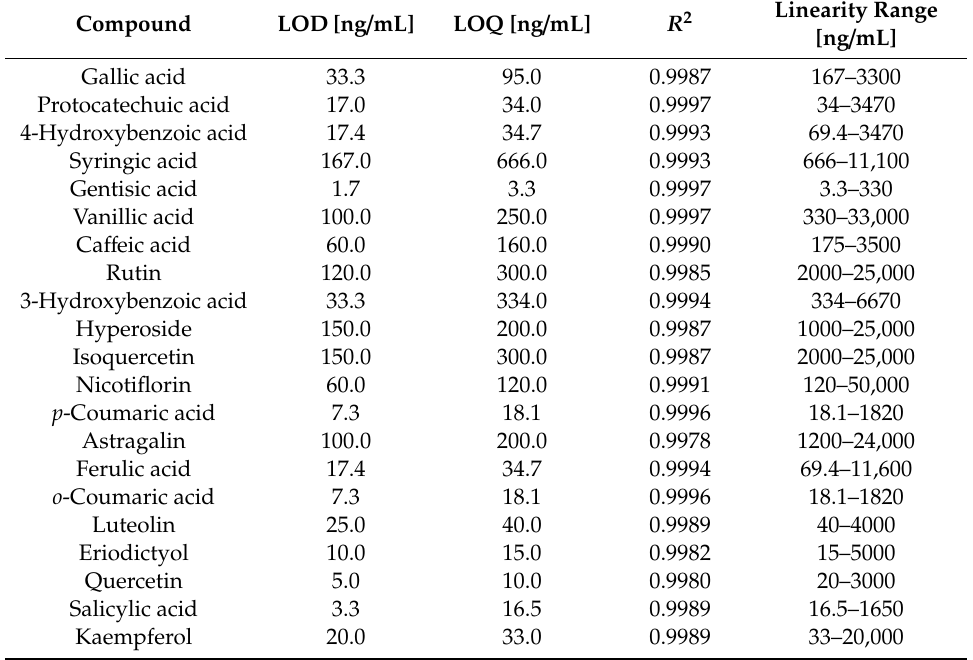
Table 2. Analytical results of LC-MS / MS quantitative method for determination of flavonoids and phenolic acids. Limit of detection (LOD), limit of quantification (LOQ) and calibration curve parameters.